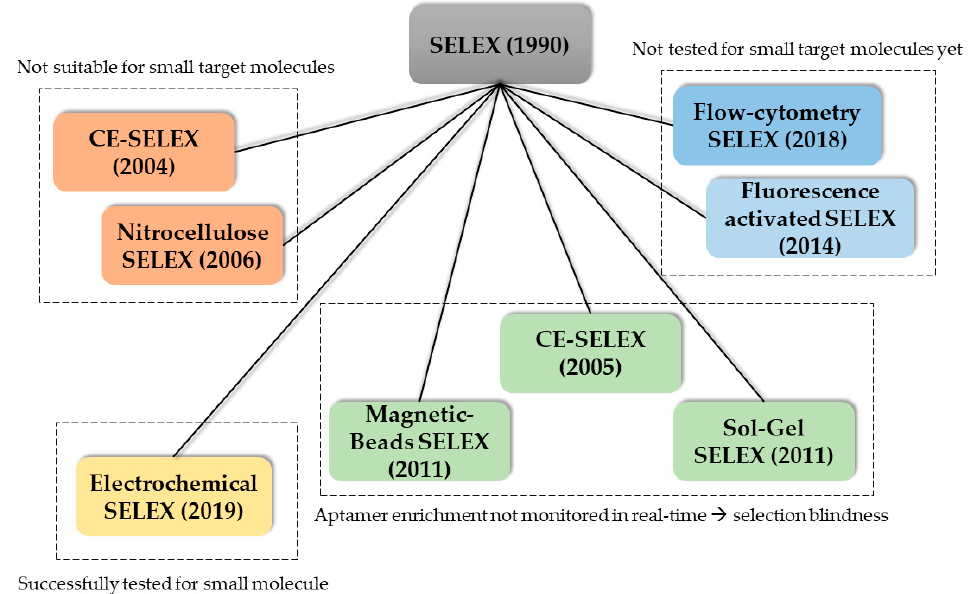
Figure 3. Overview of the reported SELEX methods used for the selection of new aptamers grouped based on their properties regarding applicability in small molecule selection and operational modes.